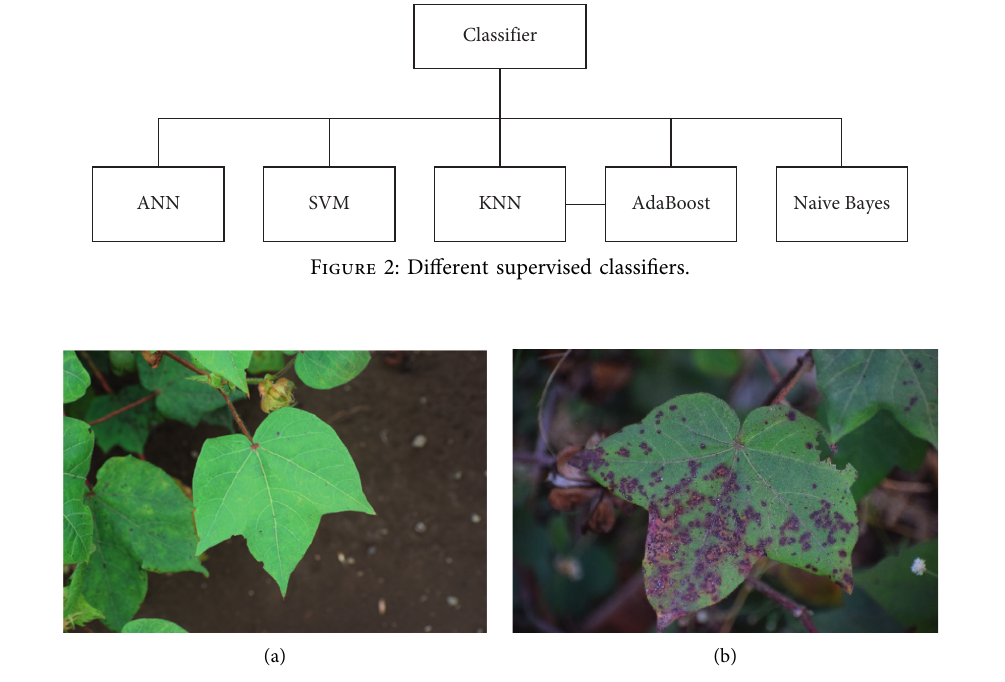
Figure 3: (a) Healthy leaf image. (b) Diseased leaf